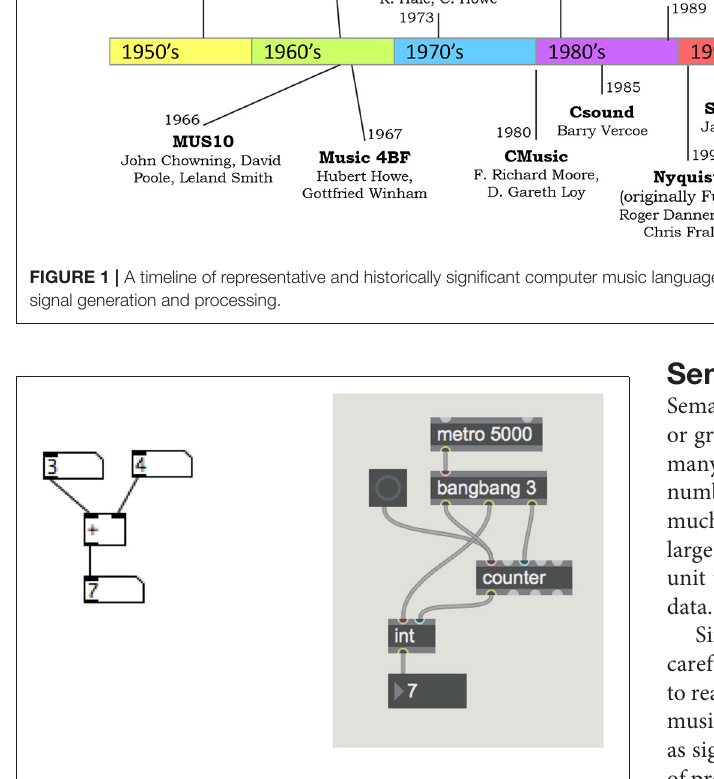
FIGURE 2 | Graphical syntax examples. At left, a Pd program to add 3 + 4. At right, a Max program to show the number of button presses in the previous 5s.